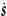
s˙ of SSOSM control.